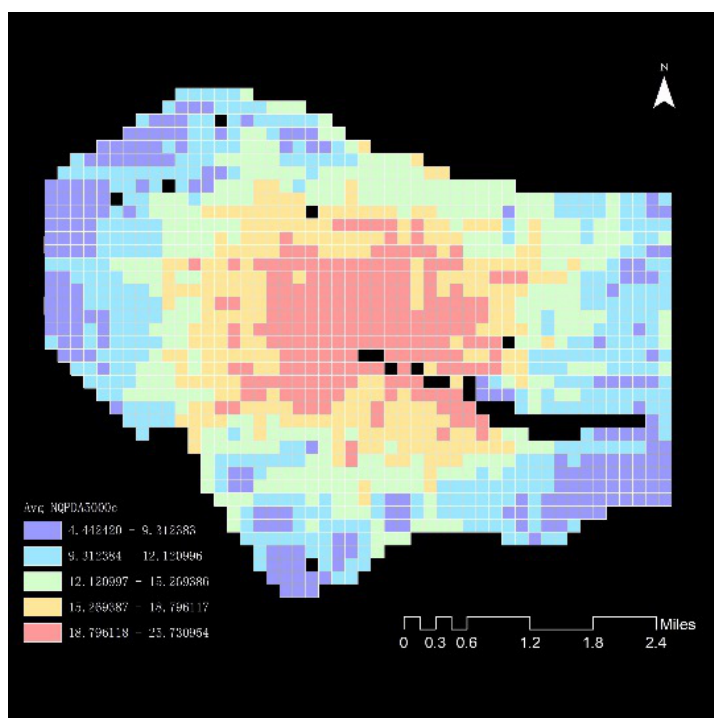
Fig. 9 Fishing net graph of the regional closeness of 3000m